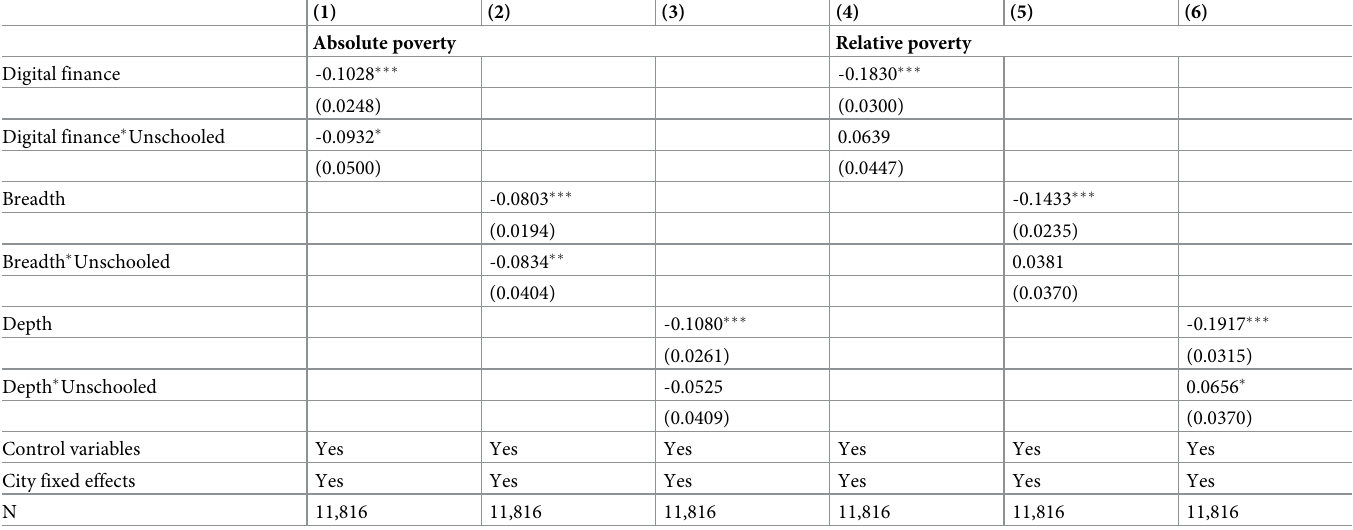
Table 15. Heterogeneity effects by